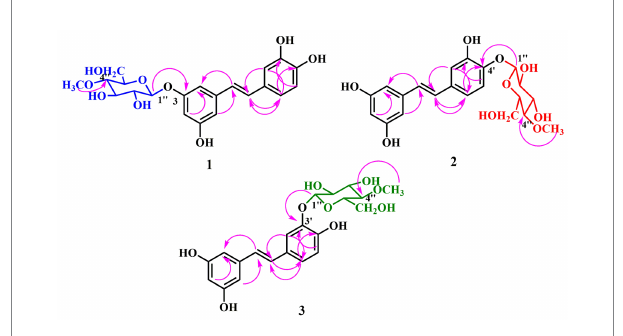
FIGURE 3 Key HMBC correlations of metabolites 1 – 3 .